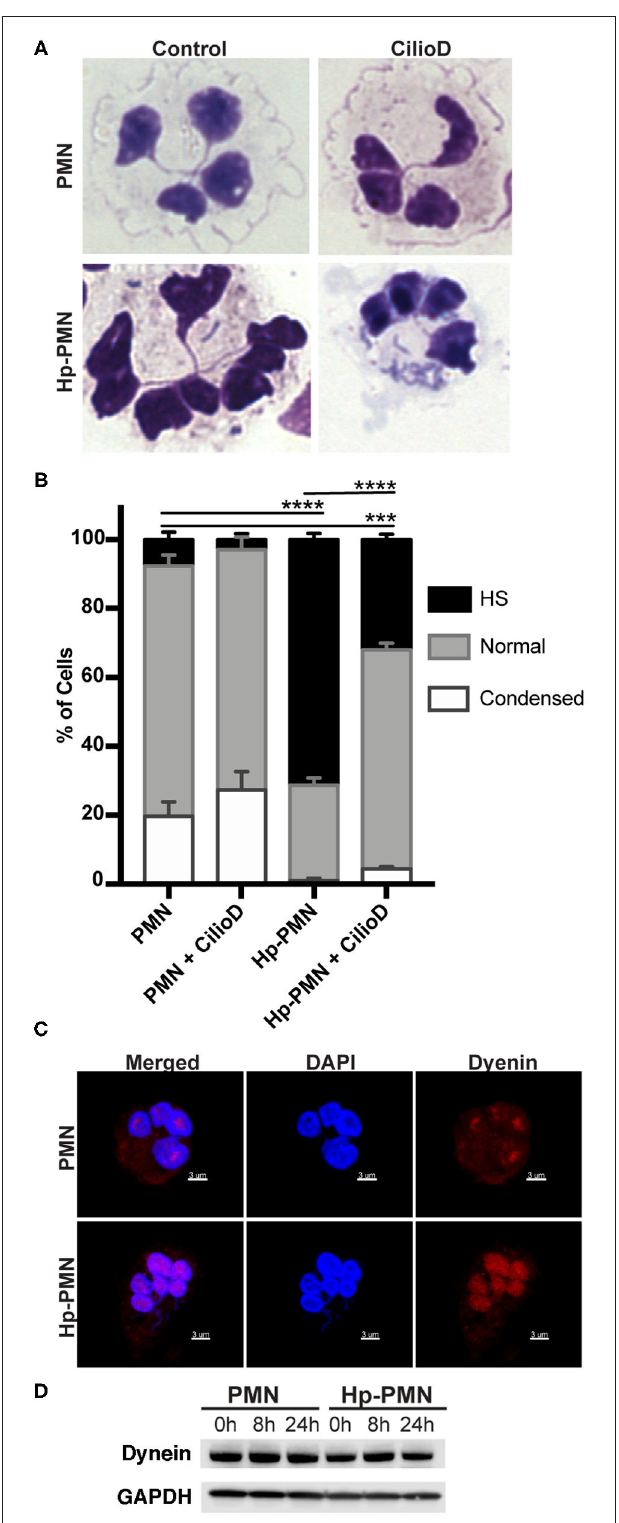
FIGURE 5 | Dynein-mediated trafficking is required for hypersegmentation. (A,B) Cells were treated with 20 µ M Ciliobrevin D for 24h in the presence and